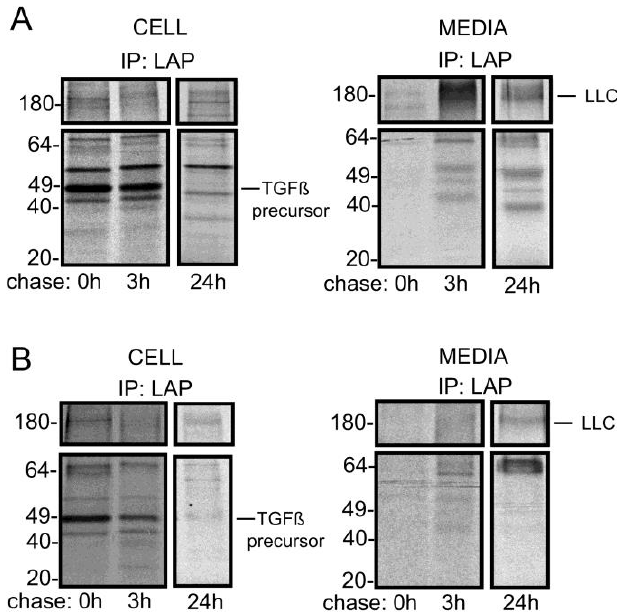
Figure 2. Accumulation of latent TGF β 1 in ML-II fibroblasts is associated with impaired secretion. Representative autoradiographs of 35 S-labeled latent TGF β 1 complexes Immunoprecipitated from control ( A ) and ML-II ( B ) human fibroblast lysates and media samples at times indicated and resolved by sodium dodecyl sulfate polyacrylamide gel electrophoresis (SDS-PAGE) (n = 4). The expected migration of the TGF β 1 precursor and the large latent complex (LLC) is shown.